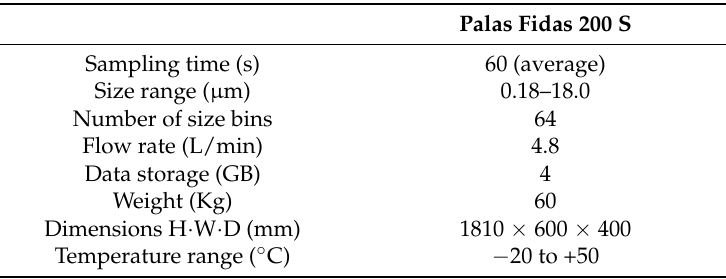
Table 2. Summary of Palas Fidas 200 operational settings [19].